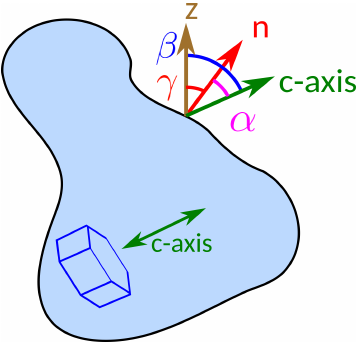
Figure 7. Time evolution of the facet orientation. The colours de- scribe α , the angle between the c axis obtained from the DCT in- formation and the normal to the interface: green represents basal faces, and red corresponds to cases where the surface is parallel to the c axis. White arrowheads point out plate-like crystals formed at the end of the experiment, where consistency between orientation and morphology can be